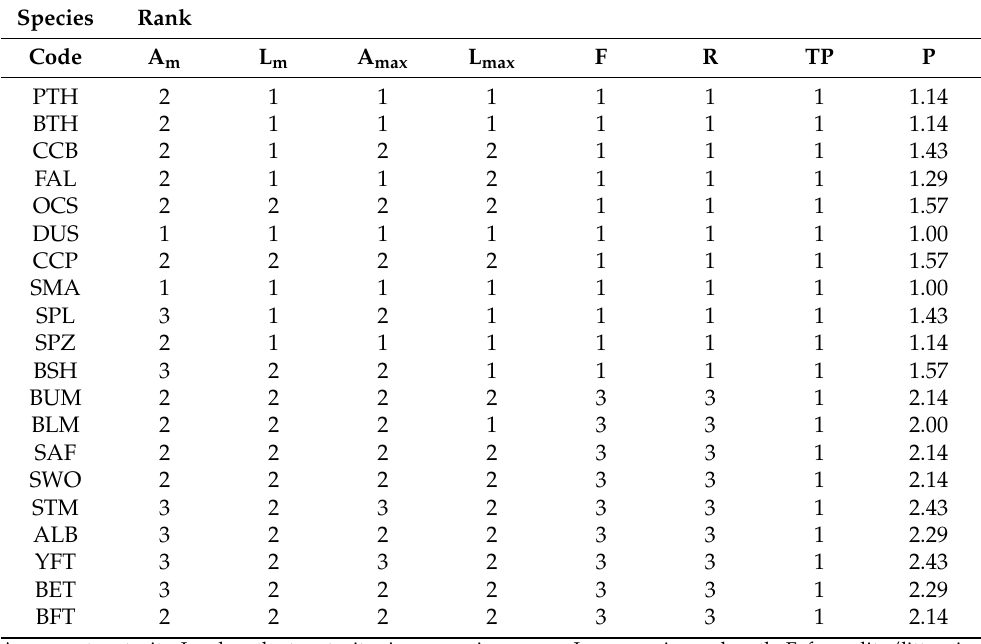
Table 3. Productivity parameters by rank in the ecological risk assessment of the 20 pelagic species in the western North Pacific. The productivity indicator (P) reflects the risk of productivity. Species Rank Code